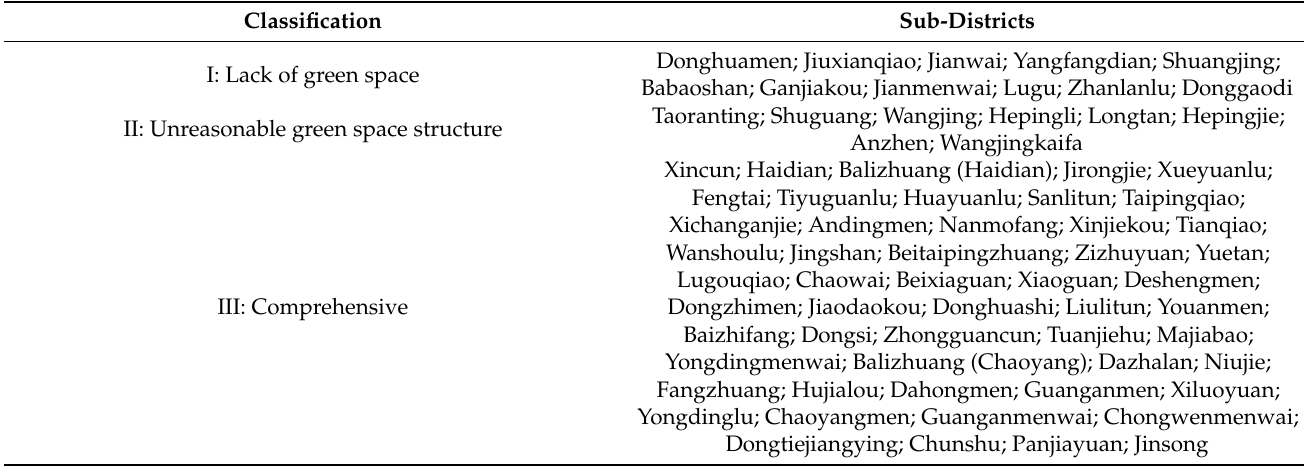
Table 4. Urban green space (UGS) optimization strategy of each sub-district within the 5th Ring Road of Beijing based on carbon sequestration services evaluation.